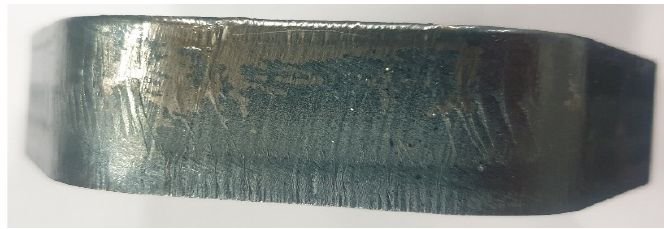
Figure A3. Edge surface quality of the cut 20 mm mild steel workpiece.